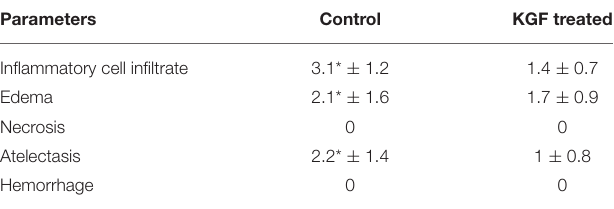
TABLE 3 | Histopathology scores for the assessed parameters.